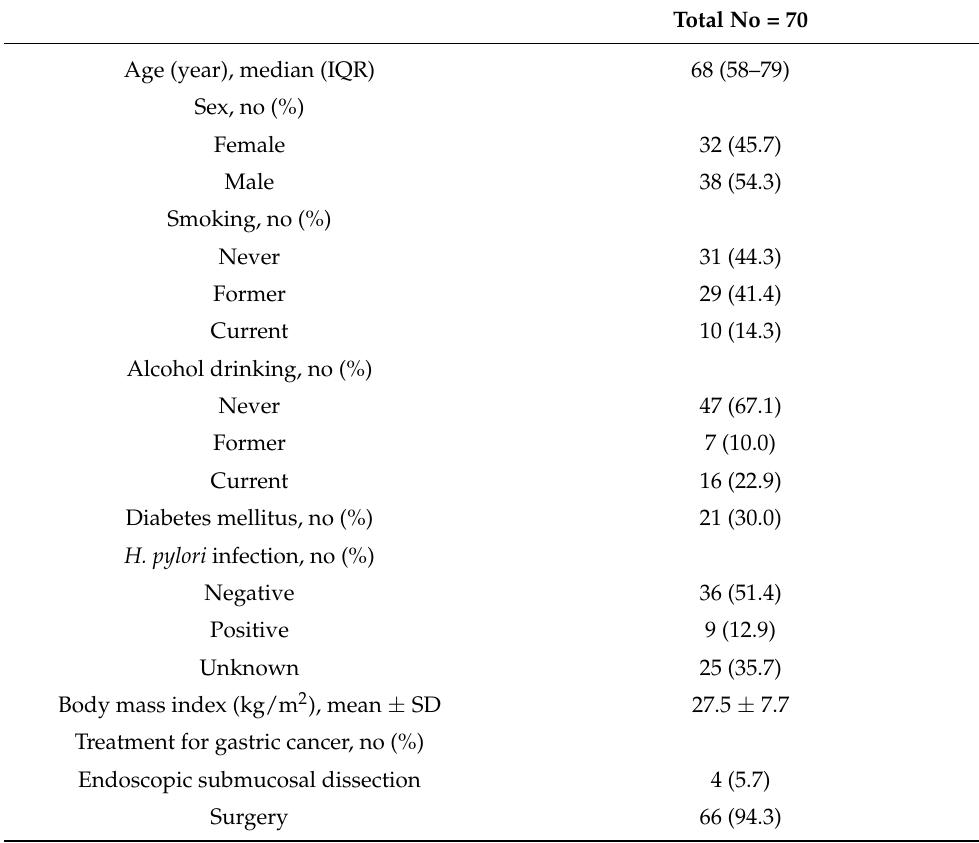
Table 1. Baseline patient demographics and clinical